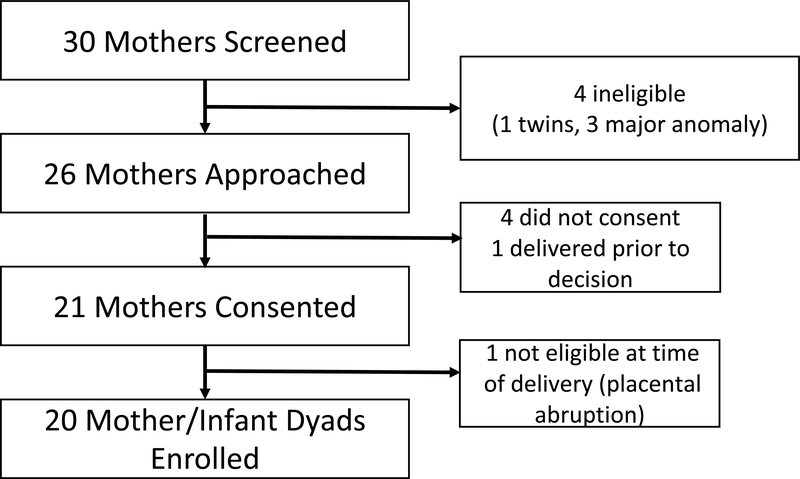
Study flow diagram